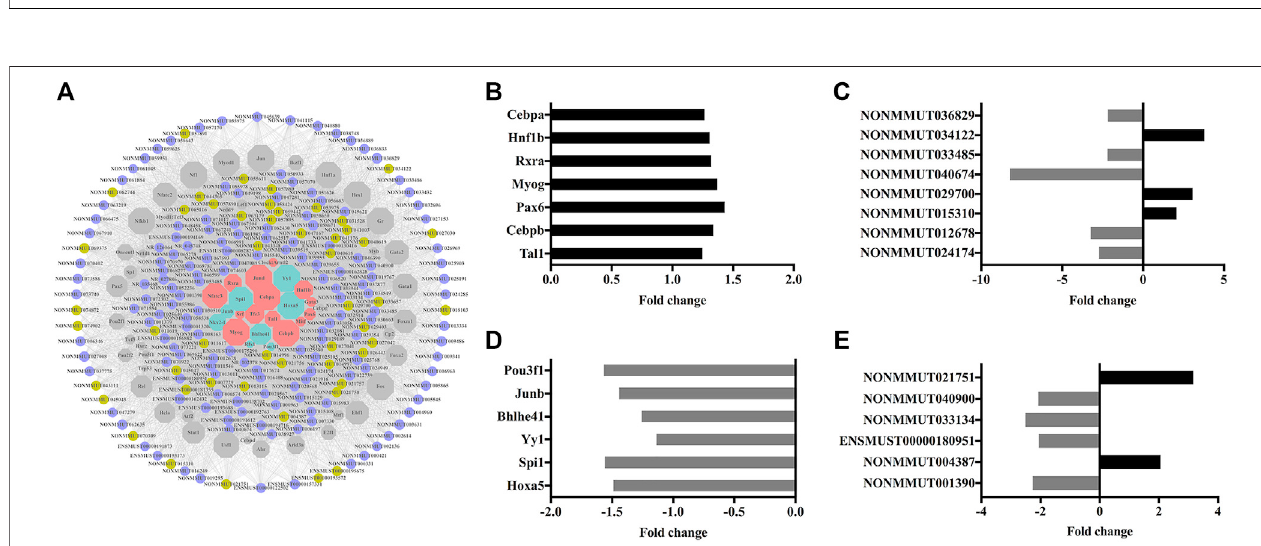
FIGURE7| ConstructionofthelncRNA – TFinteractionnetworkandidenti fi cationofdistinctlyexpressedTFs. (A) lncRNA – TFinteractionnetwork.Circlenodeswith strong yellow and orchid represent up- and downregulated lncRNAs, respectively. Hexagon nodes with soft red, slightly desaturated cyan, and gray represent up-, down-, and unregulated TFs, respectively. Histogram of upregulated TFs (B) and their downstream lncRNAs (C) . Histogram of downregulated TFs (D) and their downstream lncRNAs (E) .